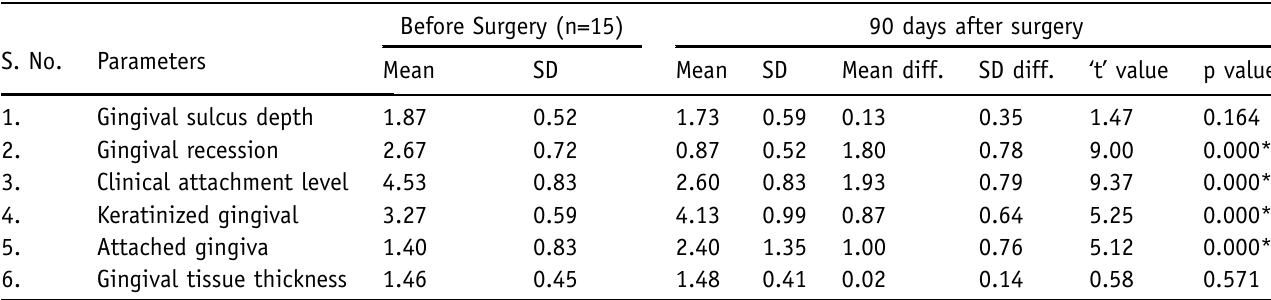
Table II. Shows evaluation of parameters for recipient teeth before and 90 days after surgery in control group (CAF).